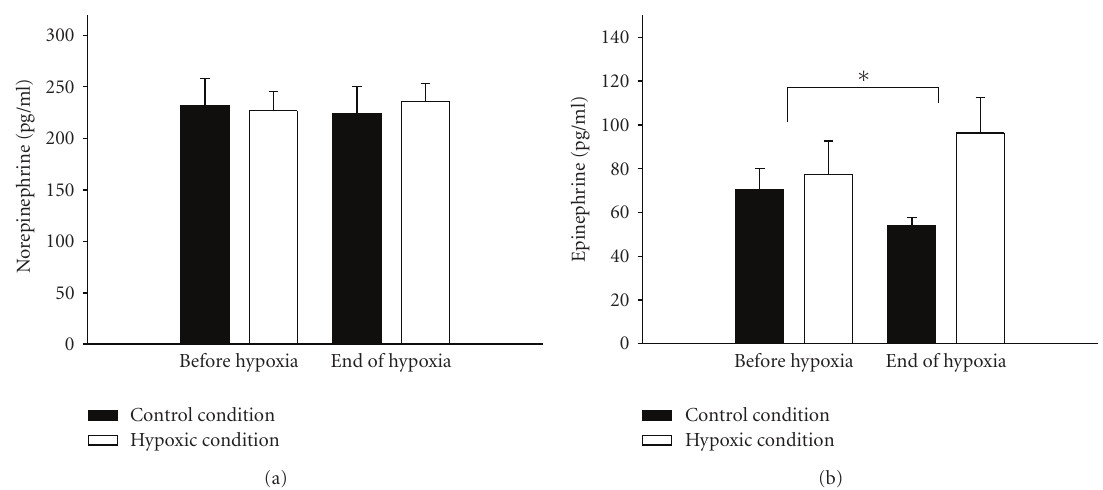
Figure 3: Mean ( ± SEM) norepinephrine concentrations (a) in the hypoxic (white bars) and the control (black bars) condition. Mean ( ± SEM) epinephrine concentrations (b) in the hypoxic (white bars) and the control (black bars) condition. Epinephrine concentrations have significantly increased in the hypoxic